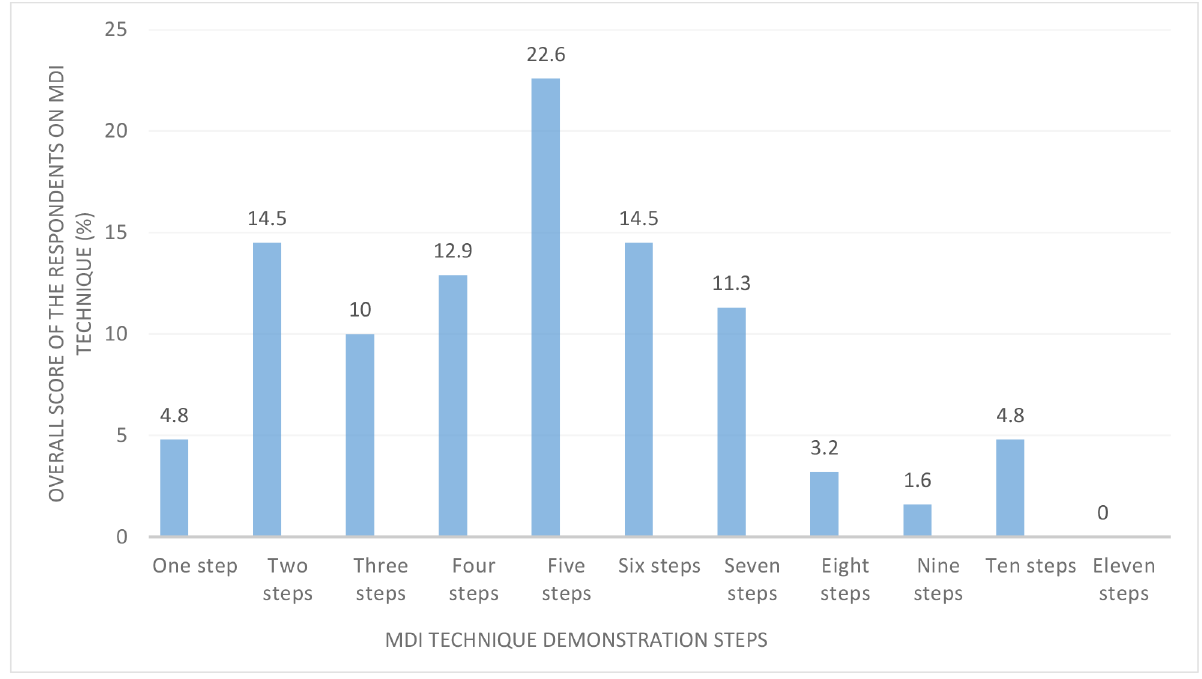
Fig 1. Overall score of the respondents on MDI technique, Gondar,